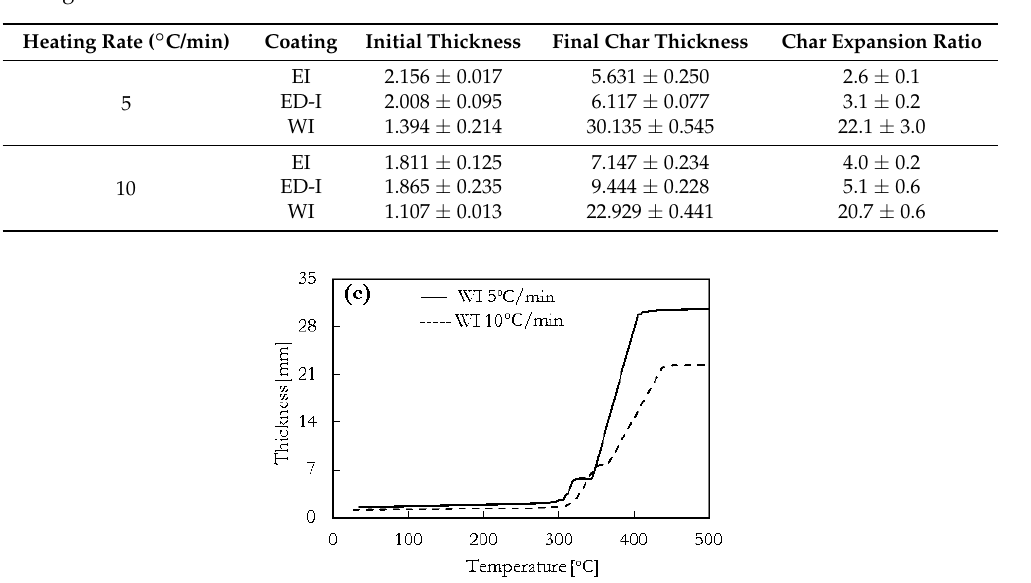
Table 3. The char thicknesses of intumescent coating samples from rheometer experiments at different heating rate.